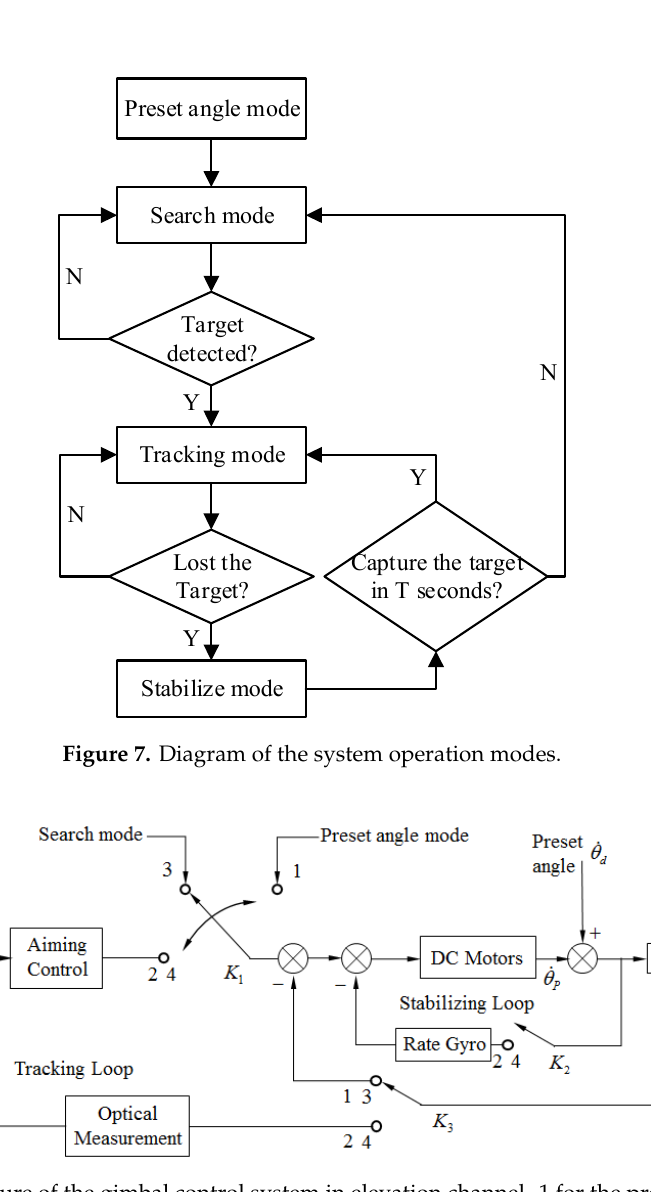
Figure 8. Architecture of the gimbal control system in elevation channel. 1 for the preset angle mode, 2 for the stabilize mode, 3 for the search mode, and 4 for the tracking